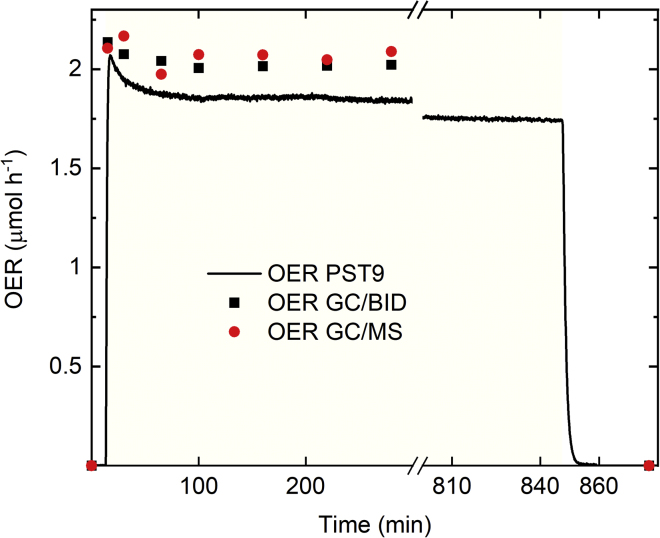
Quantitative Analysis of the Complementary GC-MS-BID System with Longer Time On-StreamAM 1.5G, 1-sun illumination, 5 mg Ru0.15/P25-PD∗, 10 mL H2O (10 mM KIO3, 1 mM TSPP). After 14 h illumination (yellow graph background indicates light-on time interval), max. TOFavg 49 h−1, final TONavg ≈ 600, final TOFavg = 86% of max. TOFavg. Max. observed ξe(AM 1.5G) = 0.2%, ξe(AM 1.5G, λ < 420 nm) = 3.8%, max. observed IQE (AM 1.5G) = 16%.